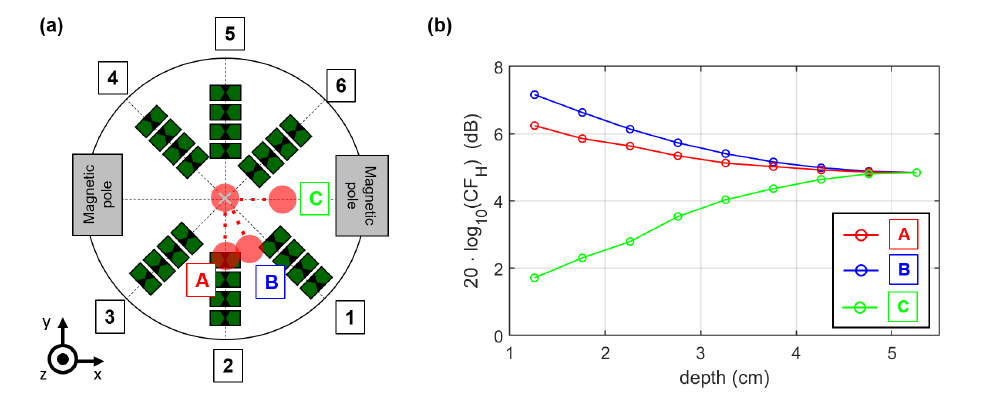
Figure 12. ( a ) Schematic of the antenna array and the target positions. ( b ) Correction factor ( CF ) in decibels (dB) depending on the target 20 · log H 10